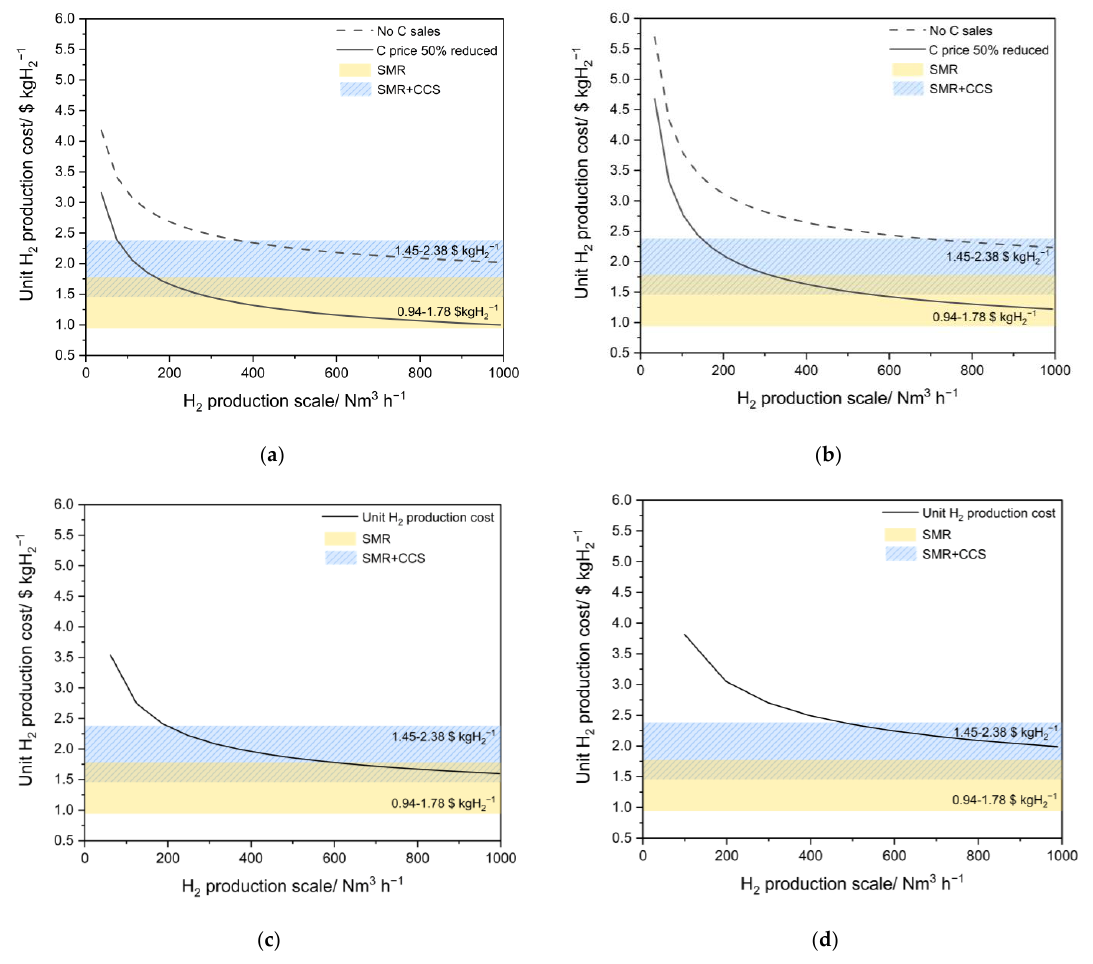
Figure 9. Results of scenario analysis up to 1000 Nm 3 h −1 for methane pyrolysis (MP) systems of ( a ) thermal methane pyrolysis (TMP-S1), ( b ) catalytic methane pyrolysis (CMP-S2), and the systems with additional gasification and WGS reaction of ( c ) TMPG-S3 and ( d ) CMPG-S4 with comparison to systems of steam methane reforming (SMR) of USD 0.94 – 1.78 kgH 2 −1 and SMR with carbon capture and storage (CCS) of USD 1.45 – 2.38 kgH 2 −1 .